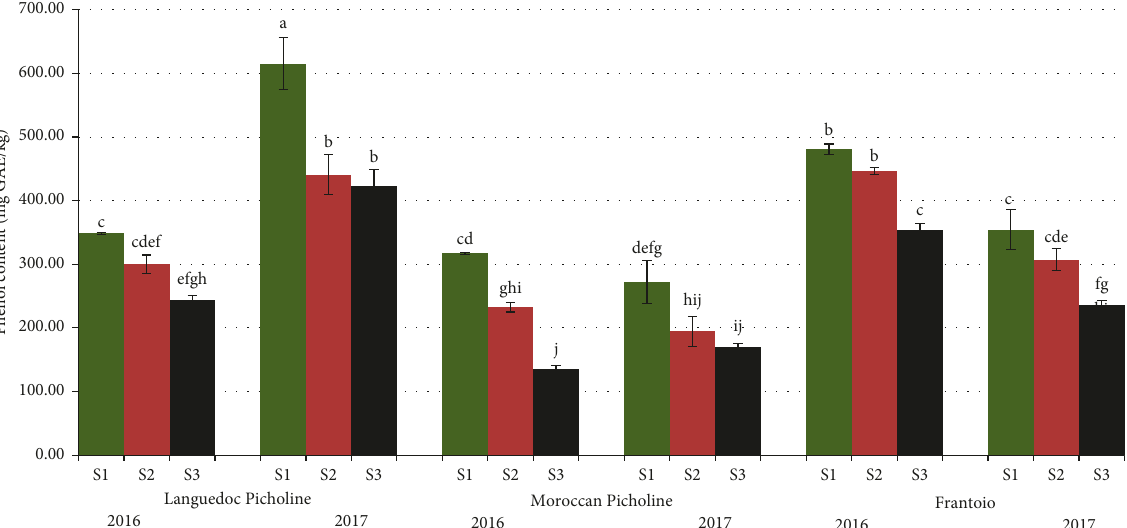
Figure 7: Phenol content in virgin olive oils of three cultivars grown in Errachidia (East Morocco) at different stages of maturity (S1: green; S2: purple; S3: black). Values are means ± standard deviation (SD) of three replications. Data followed by different letters are significantly different from each other ( P < 0 . 05) according to LSD test.